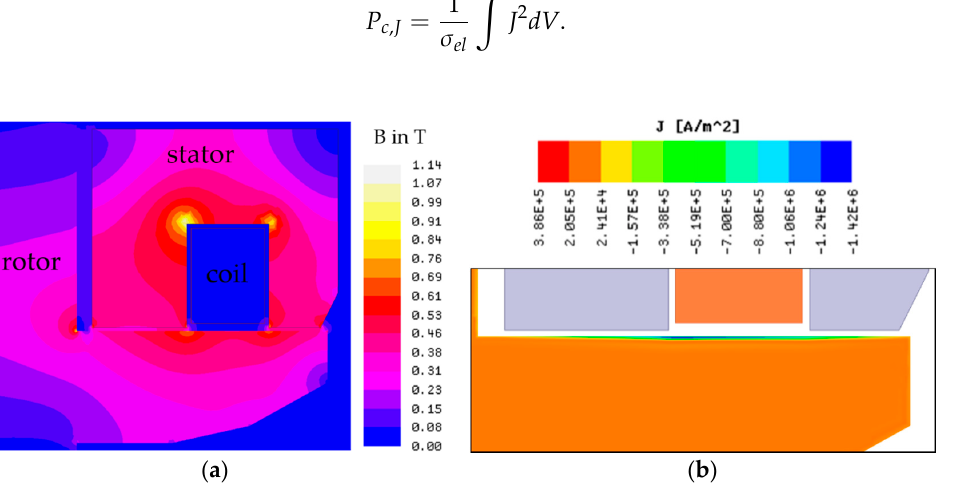
Figure 6. ( a ) Magnetic flux density in the axial active magnetic bearing (AMB); ( b ) Current density in the surface area of the thrust disk during switching of the axial AMB.